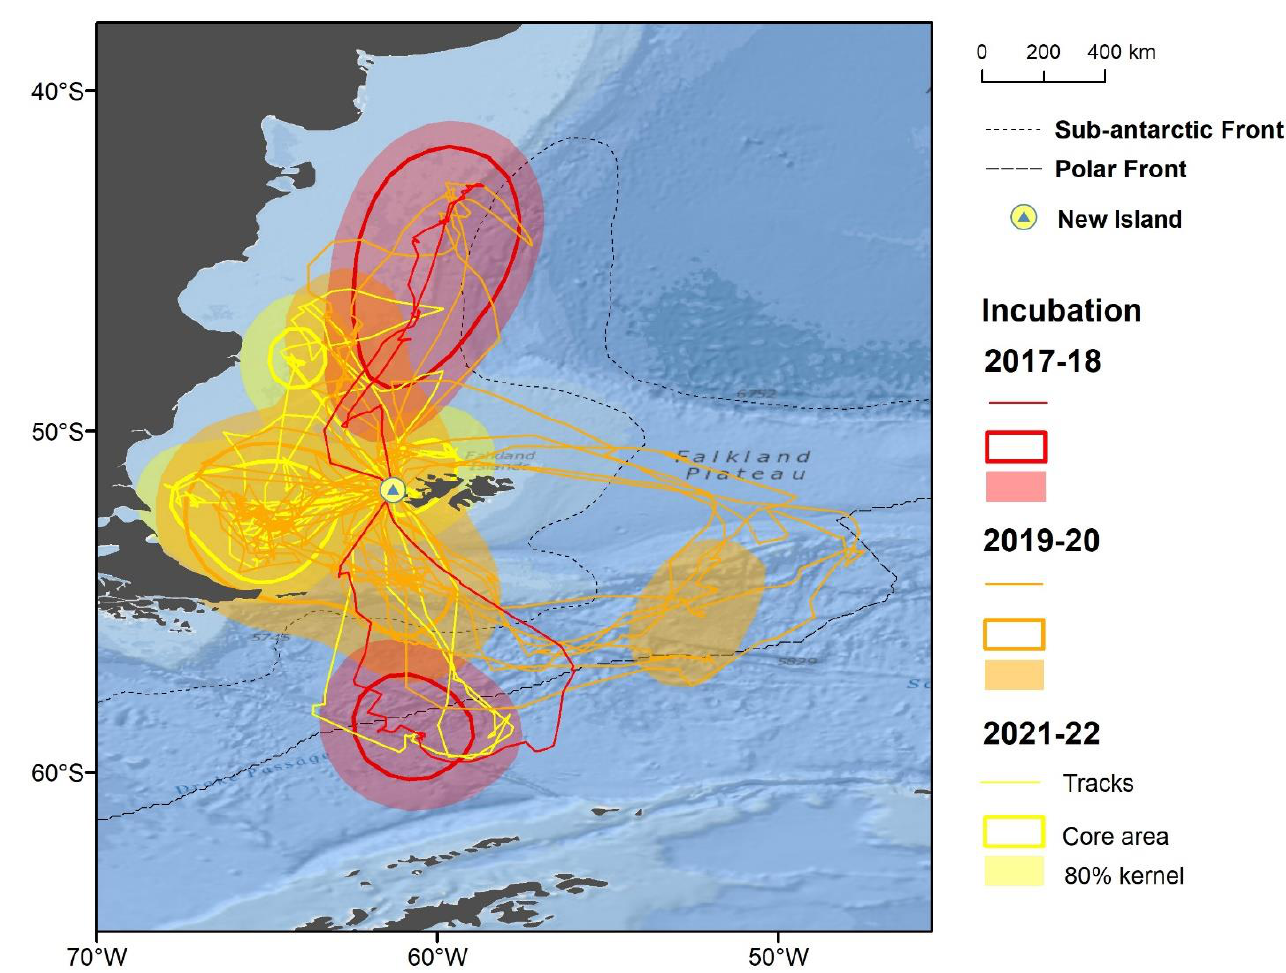
Figure 2. Tracks and main foraging areas (obtained by kernel analysis) of Thin-billed Prions from New Island during incubation, recorded in three breeding seasons. Area numbers refer to Table 3.